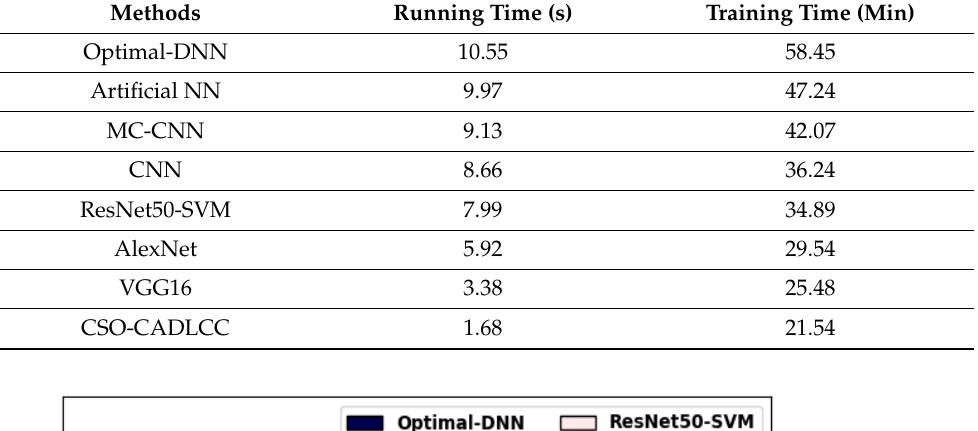
Table 3. Running time and training time analysis results of the CSO-CADLCC approach with recent methods.